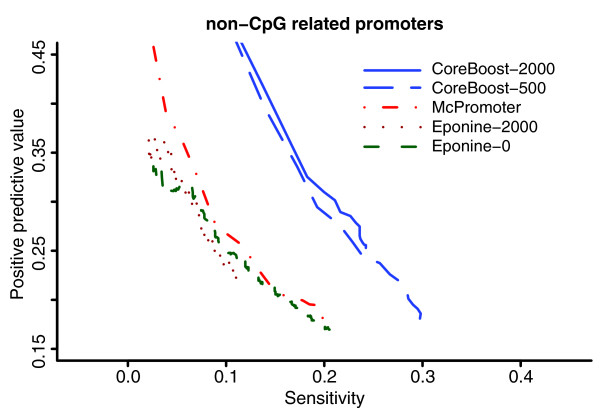
Positive predictive value versus sensitivity for non-CpG-related promoters. The solid and the long-dashed curves are for CoreBoost, with the solid one for the cases clustering predictions within 2,000 bp and the long-dashed one within 500 bp. The dot-dashed curve is for McPromoter, which clusters predictions within 2,000 bp by default. The dot and the short-dashed curves are for Eponine, with the dot one for the cases clustering predictions within 2,000 bp and the short-dashed one from the default output of Eponine. bp, base pairs.